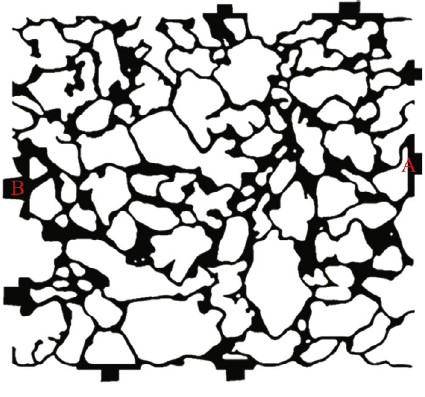
Figure 1: Pore geometry.